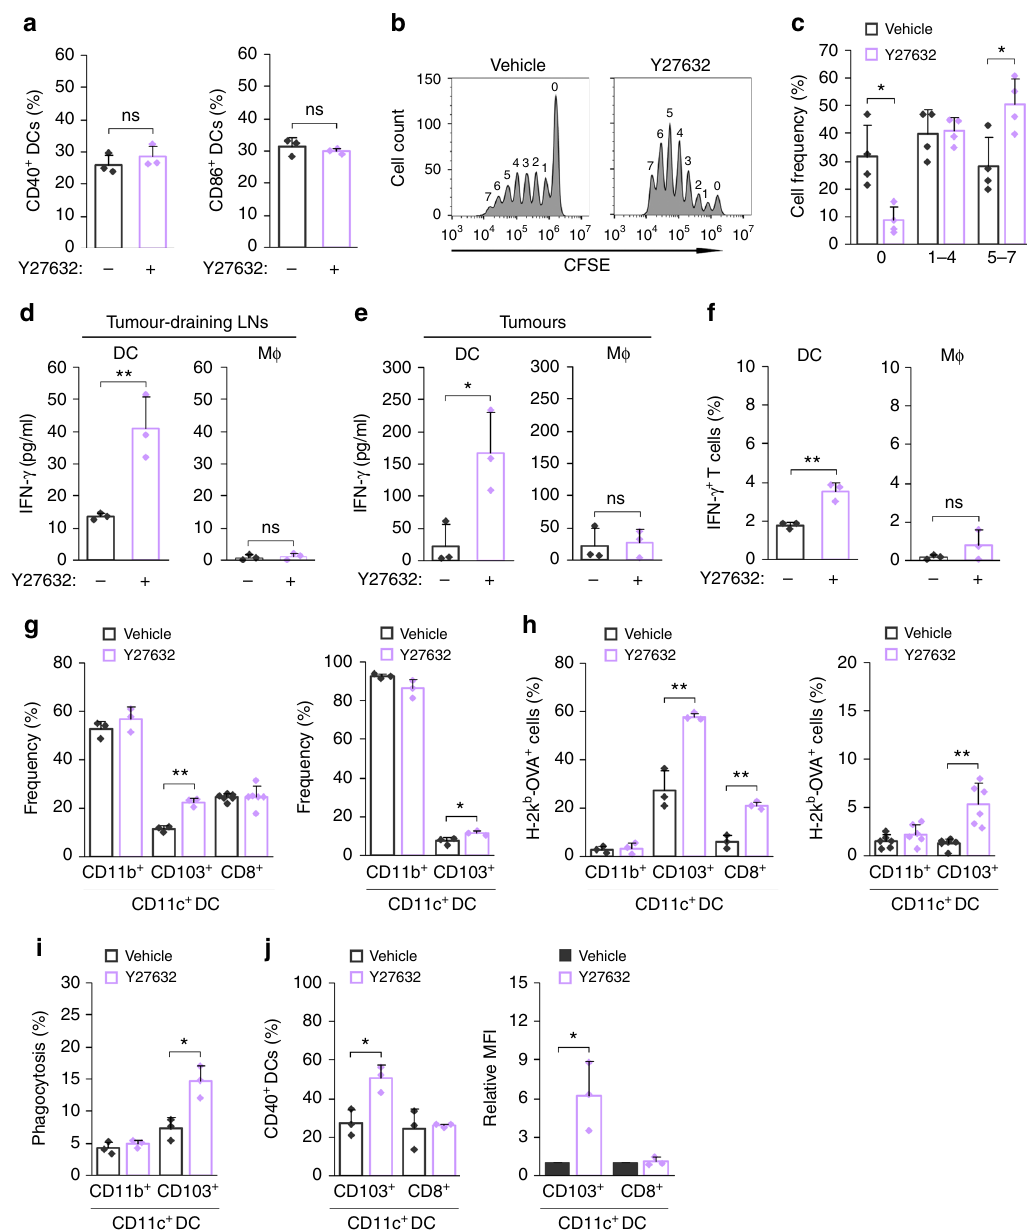
Fig. 4 ROCK blockade increases DC-mediated T cell priming. a The percentage of CD40 + and CD86 + DCs in tumour-draining LNs from B16F10-Ova tumour-bearing mice was determined by fl ow cytometry ( n = 3). b , c B16F10-Ova tumour-bearing mice were injected (i.v.) with Y27632 or vehicle. On day 20, mice were injected (i.v.) with CFSE-labelled OT-I T cells; after 3 days, the proliferation of OVA-speci fi c OT-I T cells in tumour-draining LNs was analysed by fl ow cytometry. b Representative fl ow cytometry plots. c Percentages of the indicated CFSE-labelled OT-I T cells ( n = 4). d , e CD11c + DCs or F4/80 + macrophages from B16F10-Ova tumour-bearing mice treated with Y27632 or vehicle were magnetically isolated from tumour-draining LNs ( d ) or tumours ( e ). DCs or macrophages were incubated with OT-I T cells for 72 h, and secreted IFN- γ was analysed by ELISA ( n = 3). f CD11c + DCs or F4/80 + macrophages were isolated from tumour-draining LNs from B16F10-Ova tumour-bearing mice treated with Y27632 or vehicle and co-cultured with OT-I T cells for 48 h. The percentage of IFN- γ -producing CD8 + T cells was analysed by fl ow cytometry ( n = 3). g CD11c + DCs from B16F10-Ova tumour-bearing mice treated with Y27632 or vehicle were magnetically isolated from tumour-draining LNs or tumours. The percentages of CD11b + , CD103 + and CD8 + DCs were analysed by fl ow cytometry ( n = 3 – 6). h In CD11b + , CD103 + and CD8 + DCs from tumour-draining LNs or tumours, the percentage of H-2k b - OVA + DCs was analysed by fl ow cytometry ( n = 3 – 6). i CD11c + DCs were isolated from tumours in B16F10-Ova tumour-bearing BALB/c mice injected (i.v.) with Y27632 (10 mg kg − 1 ) and incubated with CMFDA-stained B16F10-Ova for 2 h, and the percentage of CD11b + or CD103 + DCs harbouring tumour cells was determined by fl ow cytometry ( n = 3). j CD11c + DCs were isolated among tumour-draining LNs from B16F10-Ova tumour-bearing BALB/c mice injected (i.v.) with Y27632 (10 mg kg − 1 ), and the percentage and relative MFI of CD40 + cells in CD103 + or CD8 + DCs was analysed by fl ow cytometry ( n = 3). Data are presented as means± s.d. (* P < 0.05, ** P < 0.01, ns, not signi fi cant; signi fi cance determined by unpaired Student ’ s t